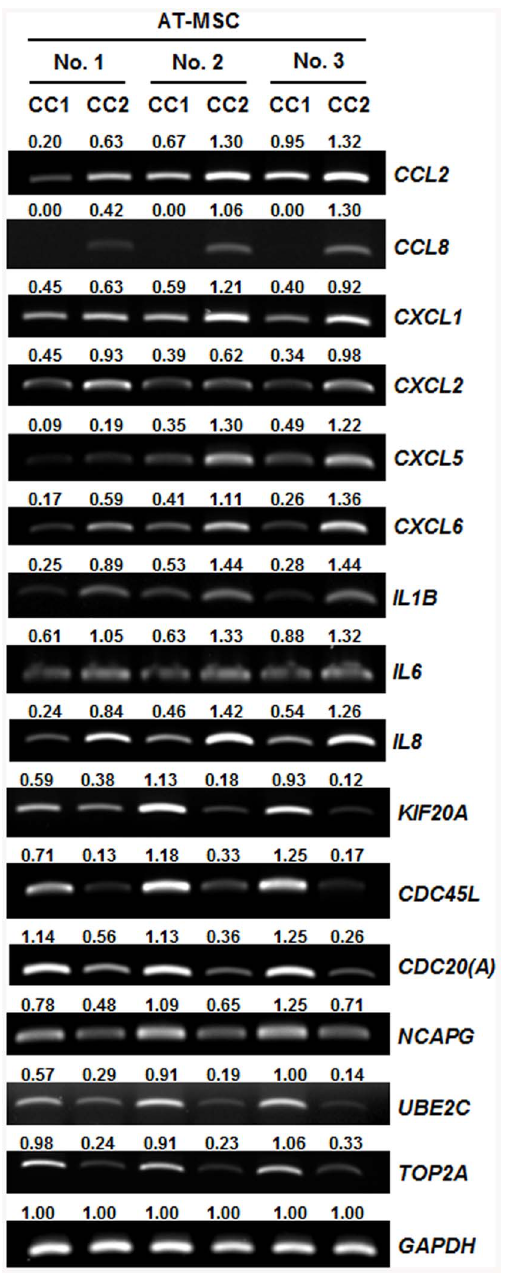
Figure 4. RT-PCR analysis of differentially expressed cytokine, chemokine and proliferation-associated genes in AT-MSC from different donors and different cell densities. The expression profile of selected genes from the microarray data was validated by semi-quantitative RT-PCR using independent samples harvested 7days after plating at different cell densities as distinct from that for microarray analysis. Quantitative gene expression data of each candidate gene indicates mRNA expression relative to GAPDH mRNA. Band intensity was normalized against that of GAPDH mRNA. Semi- quantitative RT-PCR analysis was independently performed using different MSC samples but the samples for microarray analysis. CC1, cultures plated with an initial cell density of 200 cells/cm 2 and a culture duration of 7 days; CC2, cultures plated with an initial cell density of 5,000 cells/cm 2 and a culture duration of 7